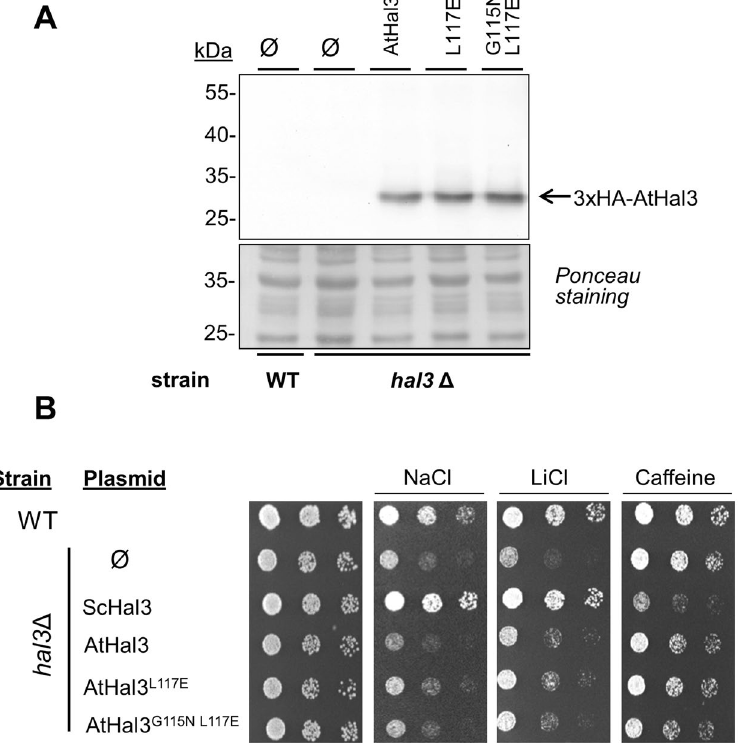
Figure 2. Immunodetection and phenotypic characterization of AtHal3 variants expressed in S . cerevisiae . ( A ) Protein extracts from cultures of wild type strain BY4741 (WT) and its hal3 Δ derivative, transformed with plasmid pWS93 (Ø) and the same plasmid expressing AtHal3a or the indicated variants, were prepared and subjected to SDS-PAGE. Proteins were transferred to membranes and the different 3xHA-tagged proteins detected with anti-HA antibodies. Ponceau staining of the membranes is shown for comparison of loading and transfer efficiency. ( B ) Wild type (WT) or hal3 Δ strains containing the indicated plasmids were spotted at OD 660 = 0.05 and at 1/5 dilutions on synthetic medium plates lacking uracil and containing NaCl (1 M), LiCl (150 mM) or caffeine (8 mM). Plates were grown for 48